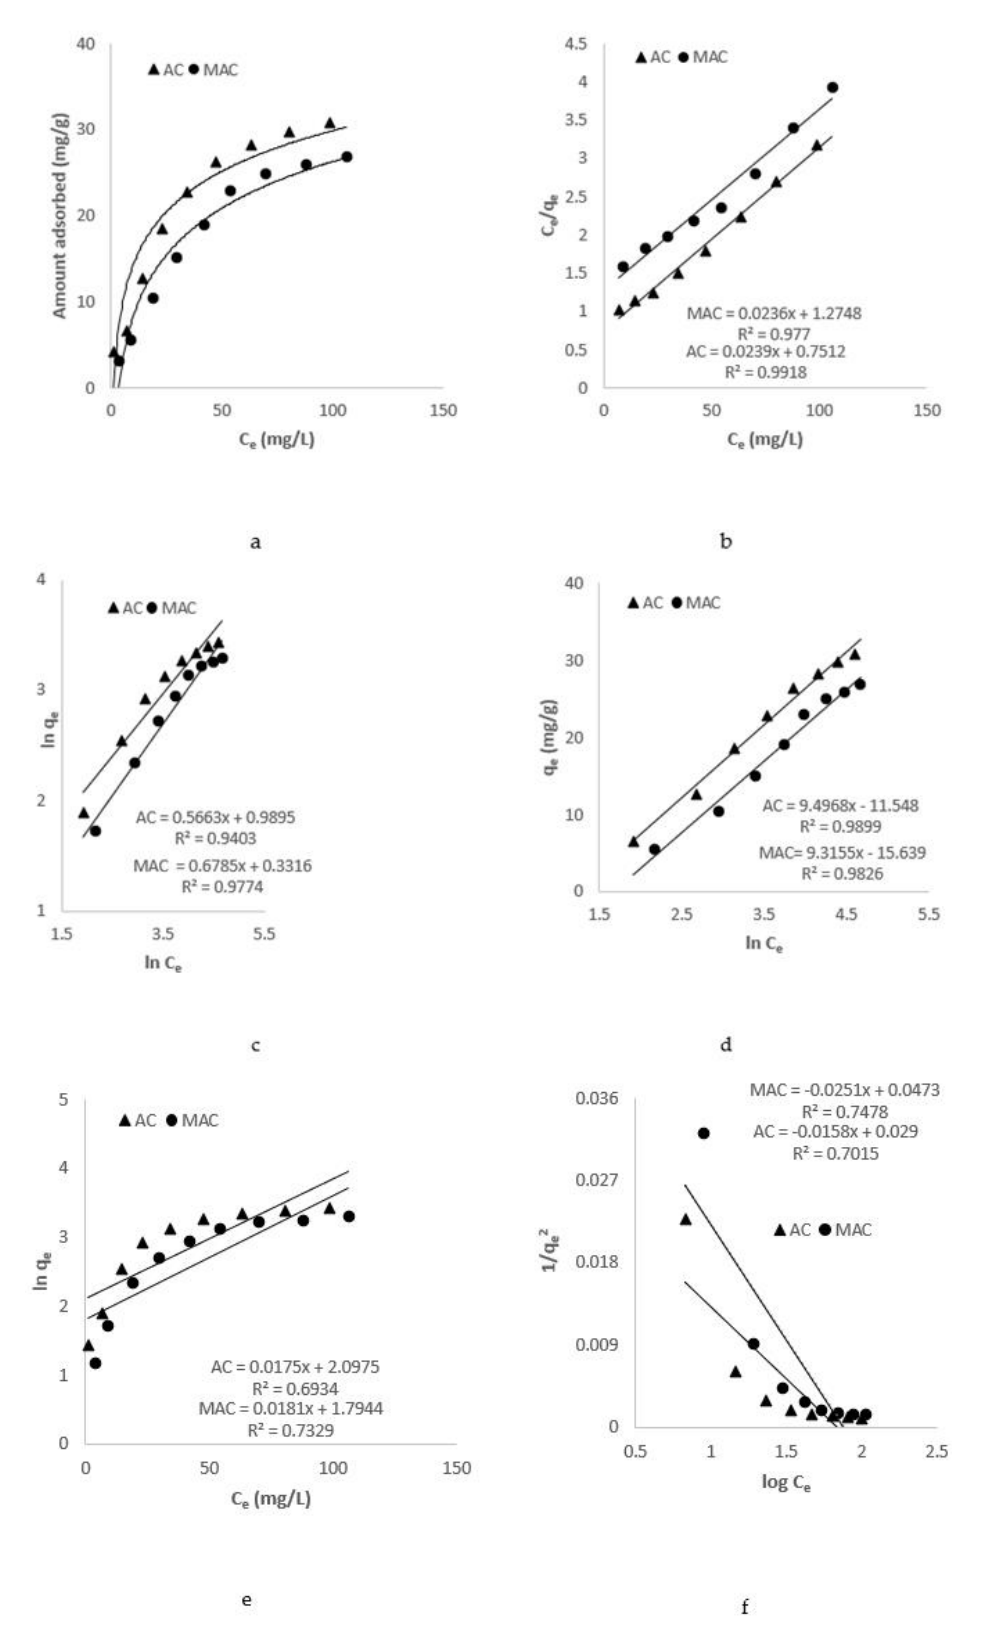
Figure 8. AZM adsorption isotherms. ( a ) Effect of concentration on adsorption of AC and MAC ( b ) Langmuir plot ( c ) Freundlich plot ( d ) Temkin plot ( e ) Jovanovich plot ( f ) Harkins – Jura plot.